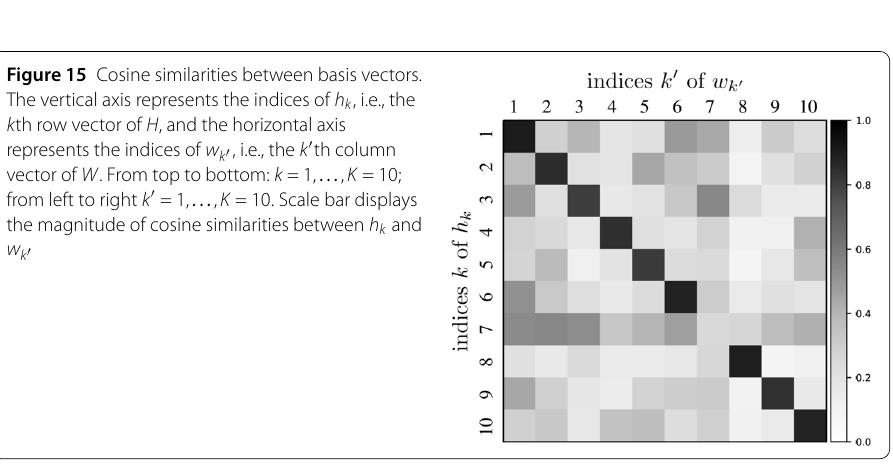
Figure 14 The box shows the pair of NMF basis vectors w k (left) and h k (right) for k = 10. See the caption of Fig. 11 for explanation